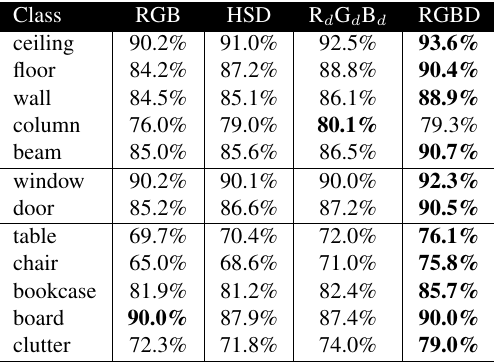
Table 2. Accuracy per class in test T1 (50% of the dataset for training and 50% for testing).